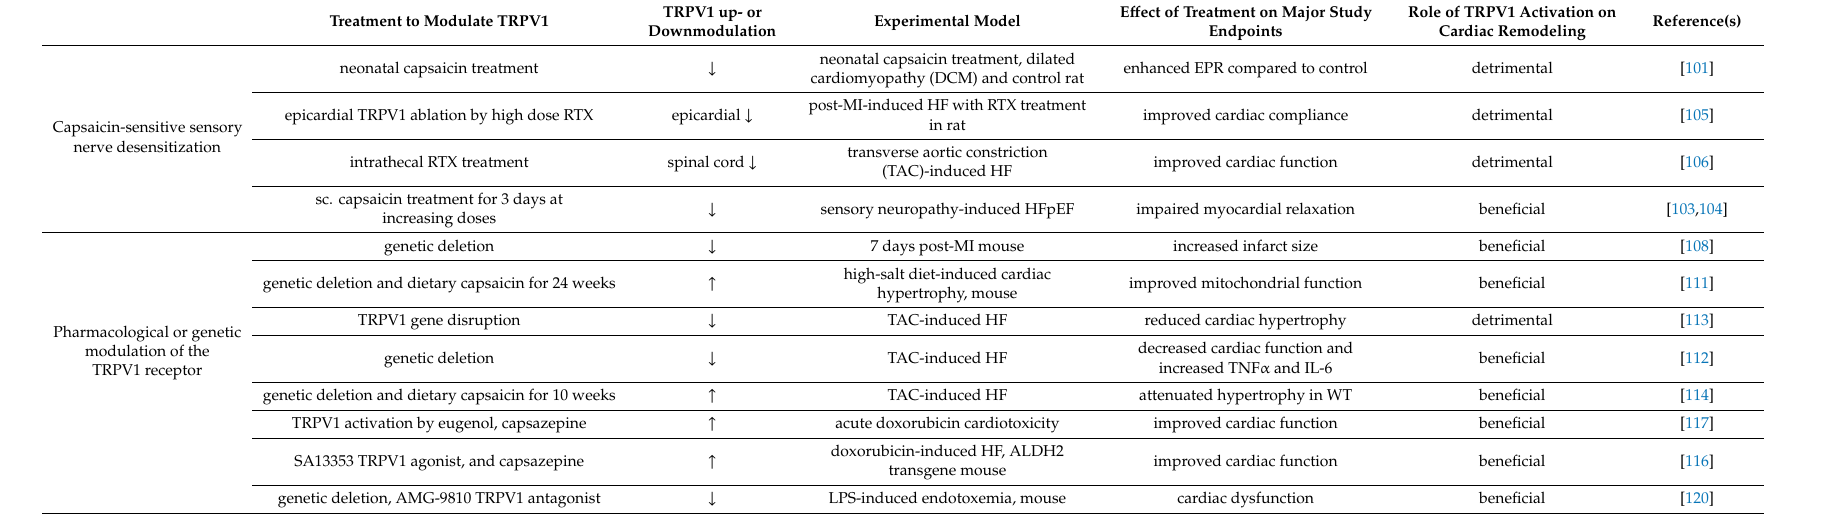
Table 3. Summary for the role of TRPV1 channels in